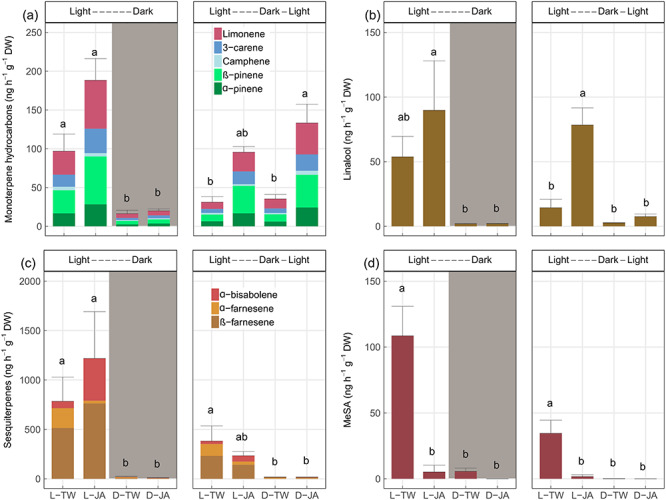
Emissions (ng h−1 g−1 DW) of volatiles, including monoterpene hydrocarbons (a), linalool (b), sesquiterpenes (c) and methyl salicylate (MeSA), (d) from the canopy of Picea abies grown either in light or dark, followed by spraying MeJA dissolved in Tween 20 or Tween 20 only: light-Tween (L-TW), light-MeJA (L-JA), dark-Tween (D-TW) and dark-MeJA (D-JA). Values are the means of four individual chambers; error bars represent ±1 SE (ng h−1 g−1 DW). During the first 5 days after spraying MeJA, volatiles were measured in the light/dark consistent with the treatments (left panel). Between day 6 and day 10, trees grown in the light were measured again, and trees in the dark were measured after 1 h of re-exposure to light (right panel). Significant differences between treatments are indicated by different letters (P < 0.05).